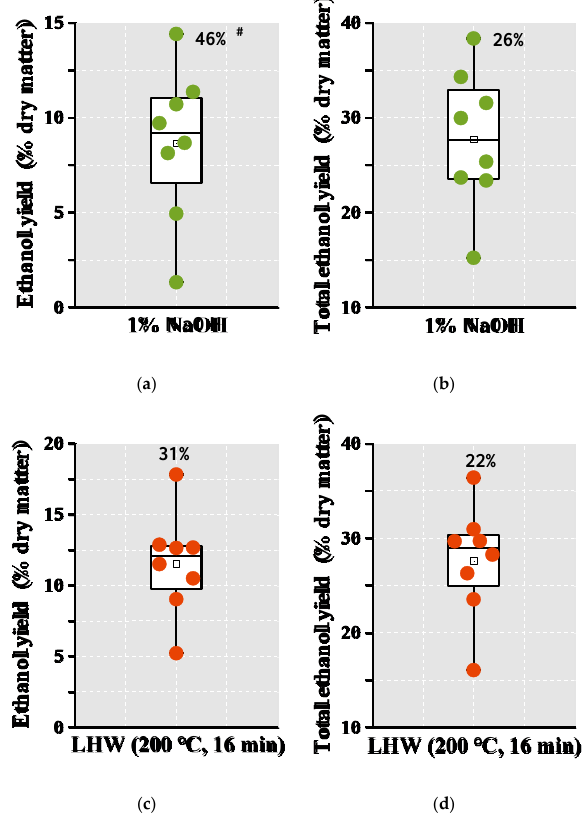
Figure 5. Variation of bioethanol production obtained from yeast fermentation among 8 total banana samples ( n = 8). ( a ) Bioethanol yields using total hexoses released from enzymatic hydrolysis after 1% NaOH pretreatments; ( b ) Estimated total bioethanol yields using all hexoses and pentoses from soluble sugars, starch, and enzymatic hydrolysis after 1% NaOH pretreatments; ( c ) bioethanol yields using total hexoses released from enzymatic hydrolysis after 16 min LHW pretreatments; ( d ) estimated total bioethanol yields using all hexoses and pentoses from soluble sugars, starch, and enzymatic hydrolysis after 16 min LHW pretreatments; # As coefficient of variation. Their results showed bioethanol yields of the banana samples from 1.3% to 14.4% (% dry matter), with CV at 46%, by using hexoses released from enzymatic hydrolysis upon 1% NaOH pretreatment (Figure 5a), which is consistent with their varied biomass enzy- matic saccharification. Based on the average xylose-ethanol conversion rate of 35% and glucose-ethanol rate of 51% as previously reported [31,32], this study further evaluated total bioethanol yields, ranging from 15.2% to 38.4% (% dry matter) with CV at 26%, by using all hexoses and pentoses from soluble sugars, starch, and enzymatic hydrolysis of alkali pretreated biomass residues (Figure 5b). Meanwhile, under 16 min LHW pretreat- ment, the banana samples also had bioethanol yields from 5.2% to 17.8% (% dry matter)